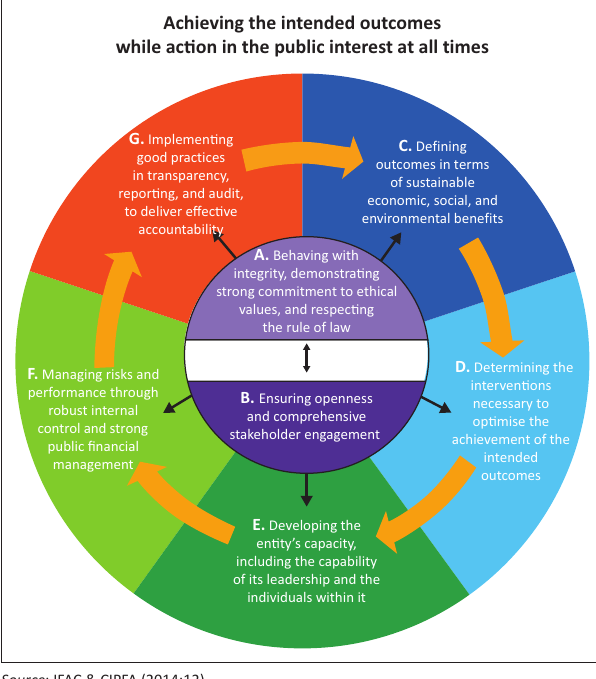
FIGURE 2: Good corporate governance in Africa: A framework illustrating relationships between the principles for good governance in the public